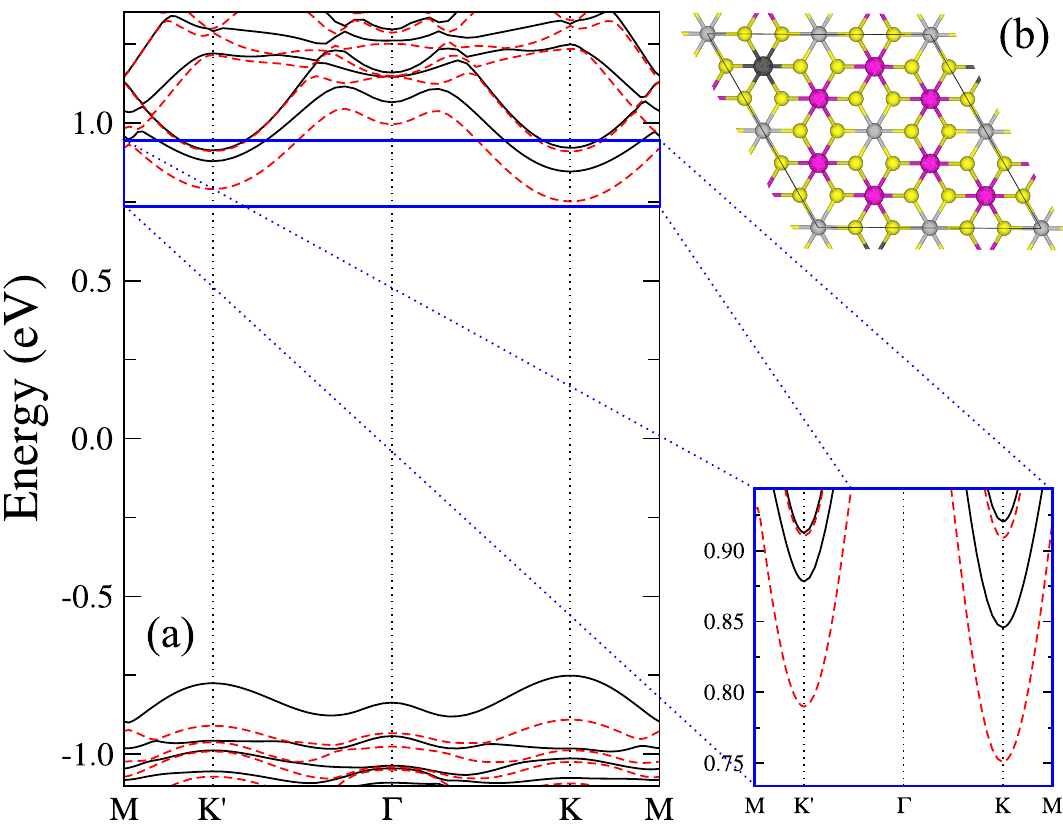
Figure 2. ( a ) DFT band structure of Zn-doped MnPSe 3 . Spin up (down) bands are represented by straight (dashed) black (red) lines. The inset shows the conduction band region in detail. ( b ) Unit cell of Zn-doped MnPSe 3 with pink, dark gray, yellow and gray spheres representing Mn, Zn, Se, and P,